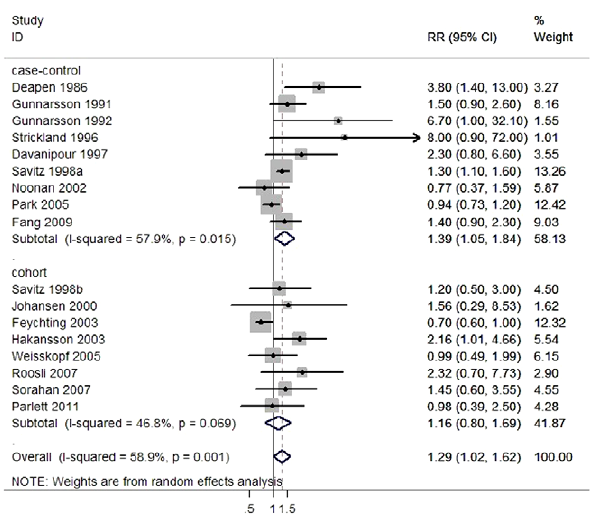
Figure 2. Forest plot of the association between ALS risk and occupational exposure to ELF-EMF.